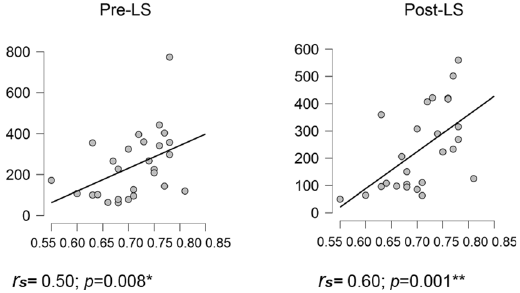
Figure 5. Correlations between best motor performance (BMP) achieved in the Learning session and mean life time (MLT) for State 7 (* p < 0.01, corrected for 4 HMM temporal parameters only; ** p < 0.002, corrected for 4 HMM temporal parameters and 7 states). The figure was created using JASP version 0.14.1, JASP Team (2021), https:// jasp- stats.